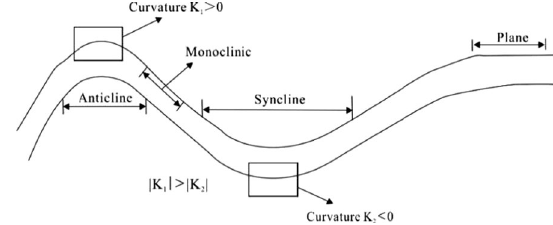
Fig. 4 Geological folds and their curvatures